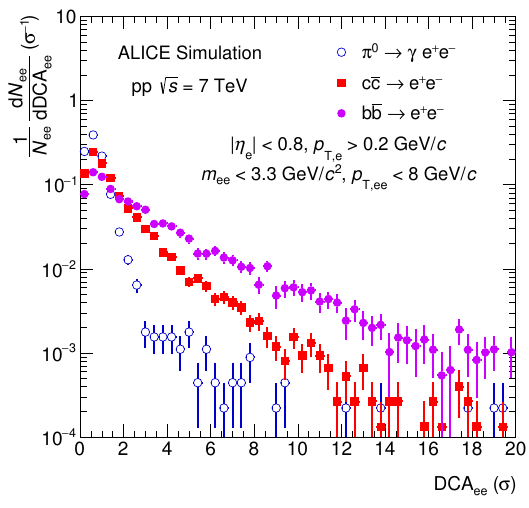
Figure 8 . DCA ee distributions of e + e (cid:0) pairs from (cid:25) 0 Dalitz decays, from semileptonic decays of charm and beauty hadrons in MC simulations (see text), integrated over m ee and p T ; ee